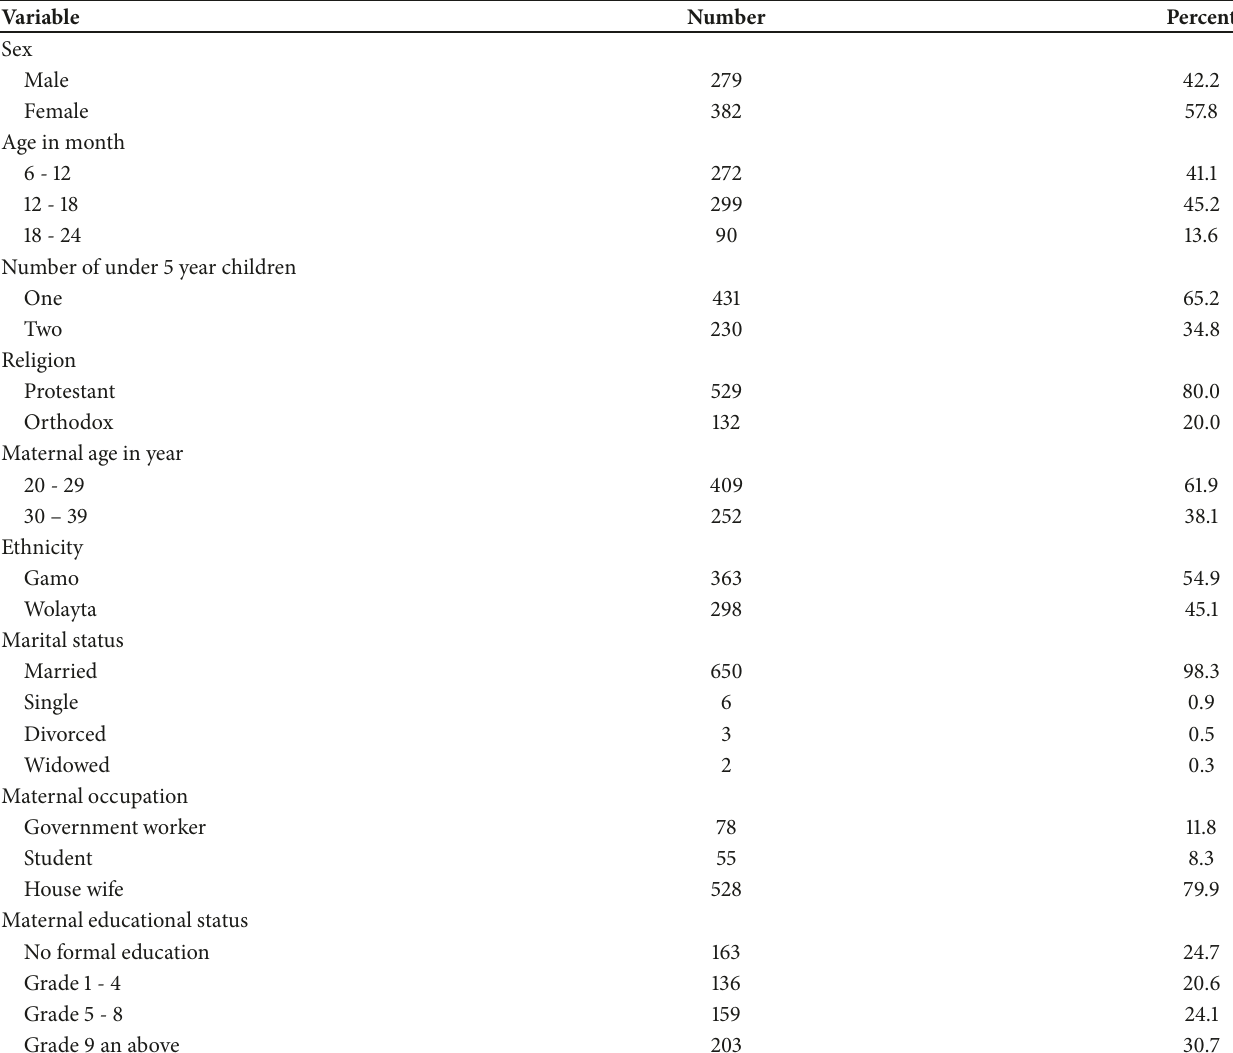
Table 1: Sociodemographic characteristics for the parent of study participant in Mirab Abaya district, Gamo Gofa Zone, SNNPR, March